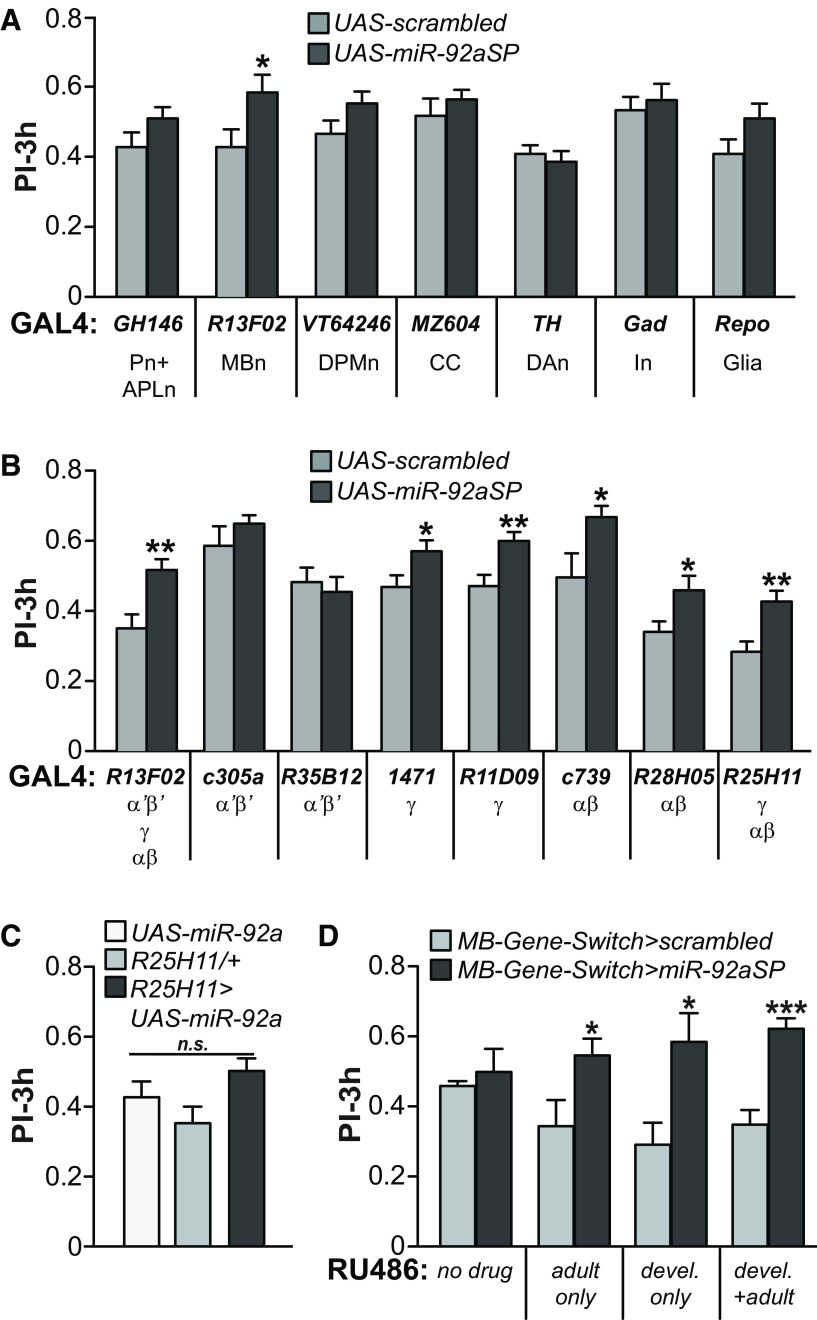
Memory enhancement from inhibiting miR-92a in MBns. A, MiR-92a inhibition in mushroom bodies enhances 3-h memory. The UAS-scrambled and UAS-miR-92aSP flies were crossed to a battery of GAL4 lines that drive expression in specific populations of neurons. Most of the drivers promote expression in neurons of the olfactory pathway. The GAL4 drivers used and abbreviations of their expression domains are shown below the bar graph. Note that there is some variation in the scores of the control genotypes because of using different GAL4 drivers. Pn: projection neurons, APLn: anterior paired lateral neuron, DPMn: dorsal paired medial neuron, CC: central complex, DAn: dopaminergic neurons, In: inhibitory neurons. PIs are the mean ± SEM with n = 12. Two-tailed, two-sample Student’s t tests for each driver expressing miR-92aSP compared with expression of the scrambled control, *p < 0.05. B, MiR-92a spatial mapping to subsets of MBns. Two independent drivers were used for each type of MBn: α’β’, γ, and αβ. The GAL4 drivers employed and their expression in the three broad types of MBns are shown below the graph. PIs are the mean ± SEM with n = 12. Two-tailed, two-sample Student’s t tests for each driver expressing miR-92aSP compared with expression of the scrambled control, *p < 0.05, **p < 0.01. C, Overexpression of miR-92a does not affect 3-h memory. MiR-92a was overexpressed in αβ and γ MBns using R25H11-GAL4. Three-hour olfactory memory performance of R25H11-GAL4>UAS-miR-92a flies was compared with GAL4-only and UAS-only controls. PIs are the mean ± SEM with n = 14. One-way ANOVA followed by Bonferroni’s post hoc tests. n.s., not significant. D, Memory enhancement occurs from miR-92a inhibition during both development and adulthood as assayed using the Gene-Switch system. Administration of RU486 during development (devel), adulthood (adult), or both (devel + adult) modulates mushroom body expression of miR-92aSP controlled by the MB-Gene-Switch driver. Note that RU treatment either during development or adulthood alters the PIs of the control genotype. PIs are the mean ± SEM with n = 6–8. Two-tailed, two-sample Student’s t tests for each RU486 feeding condition, *p < 0.05, ***p < 0.001.